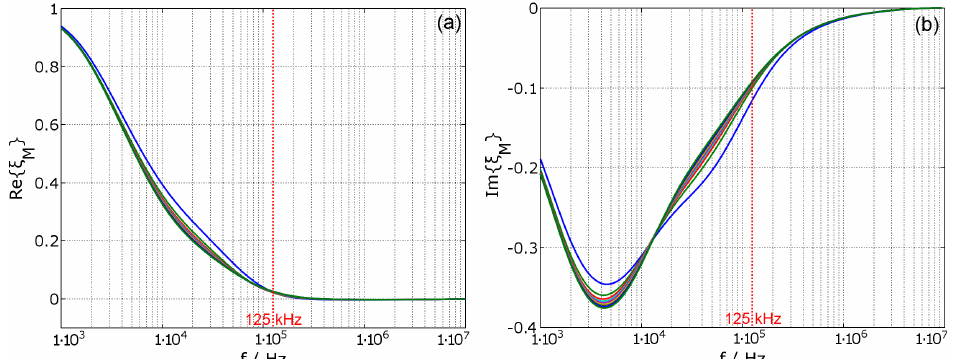
Figure 5. Correction factor for the mutual inductance χ M , split into real part ( a ) and imaginary part ( b ) for coil configuration ’A’ ( N A = 200 and